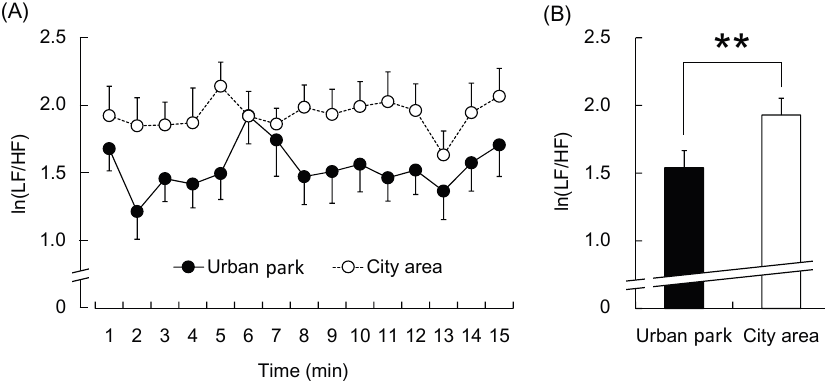
Figure 3. The 1-min averages and the overall mean ln(HF) value of heart rate variability during the urban park walk and the city area walk. ( A ) Change in each 1-min ln(HF) value; ( B ) Overall mean ln(HF) values. N = 20, mean ± standard error. ** p < 0.01, determined by the paired t -test (one-sided).